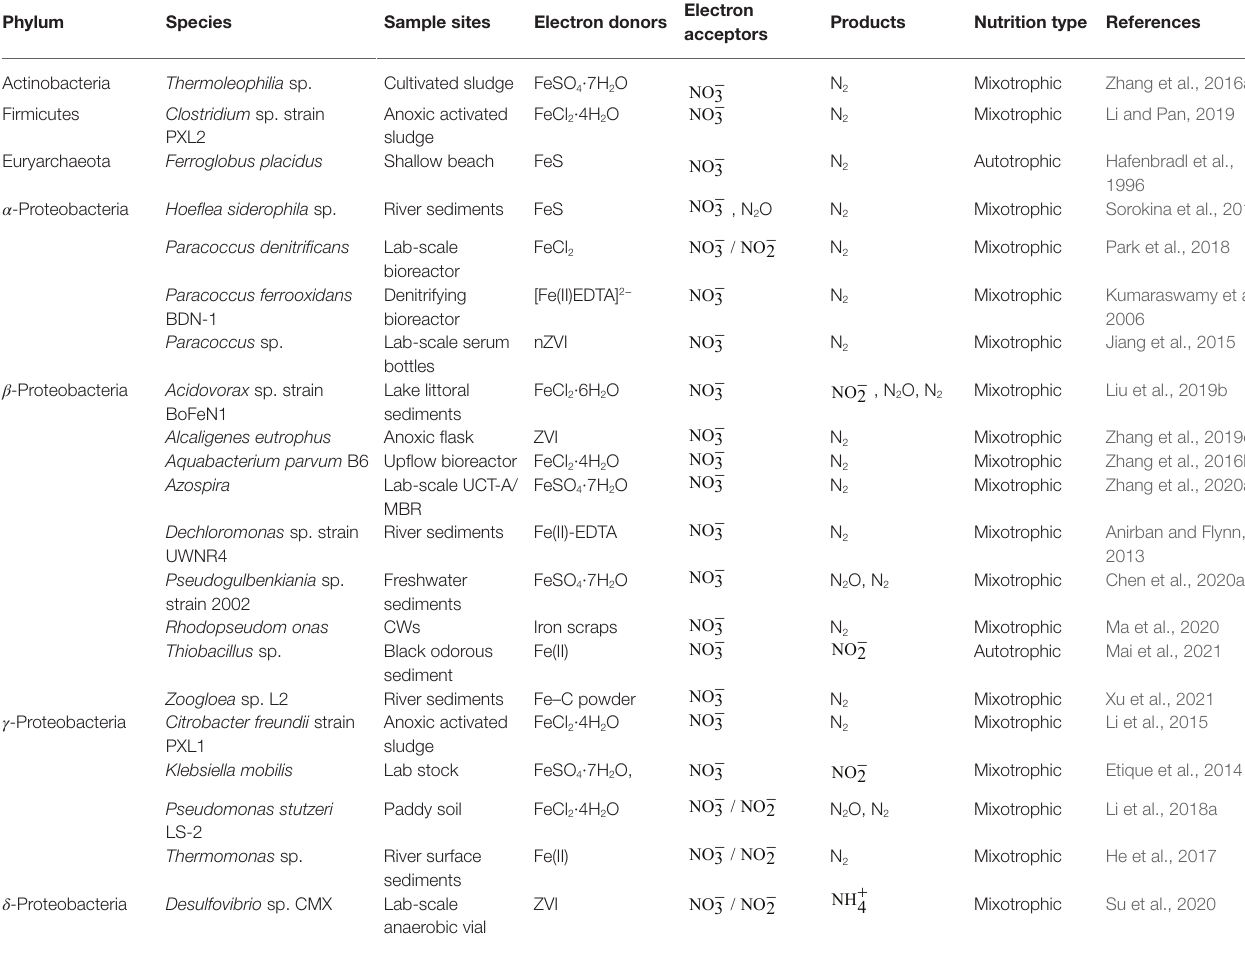
TABLE 2 | ZVI/Fe(II)-oxidizing microorganisms for NO / NO 2 3 − −